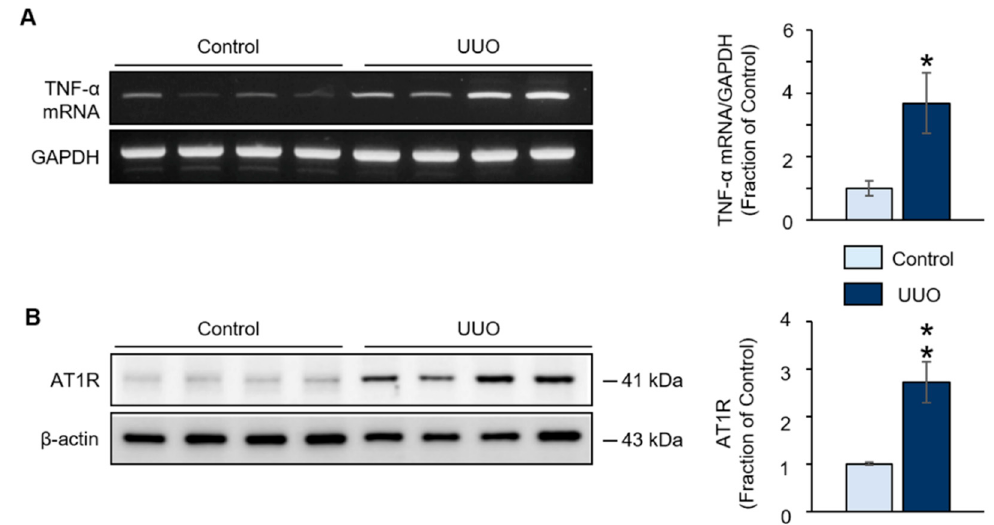
Figure 3. ( A ) Reverse transcription polymerase chain reaction (RT-PCR) analysis of tumor necrosis